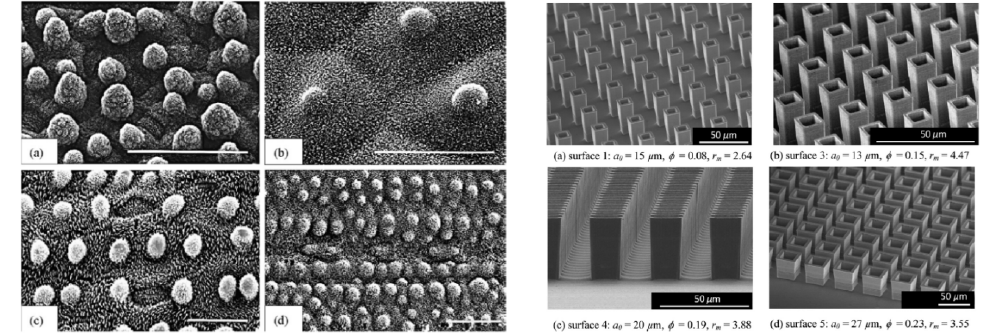
Figure 25. (left four photos) Examples of micromorphologies for water-repellent leaf surfaces of ( a ) Nelumbo nucifera and ( b ) Lupinuspolyphyllos (bars = 50 m); and ( c ) Gladioluswatsonioides and